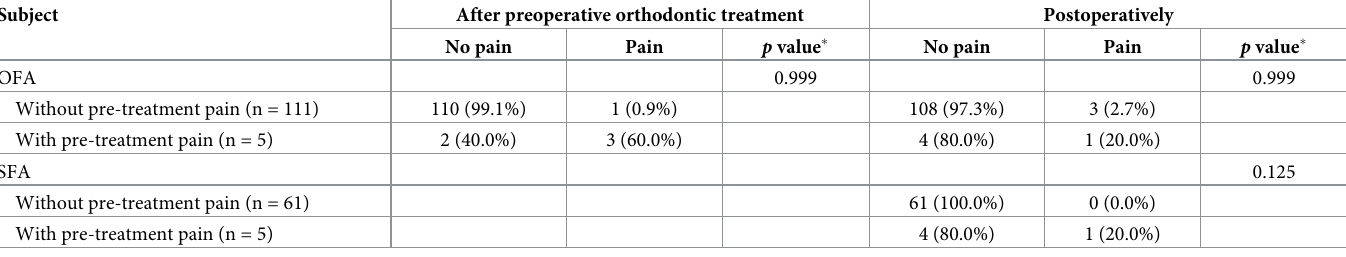
Abbreviation: TMJ, temporomandibular joint; OFA, orthodontics-first approach; SFA, surgery-first approach. � By McNemar